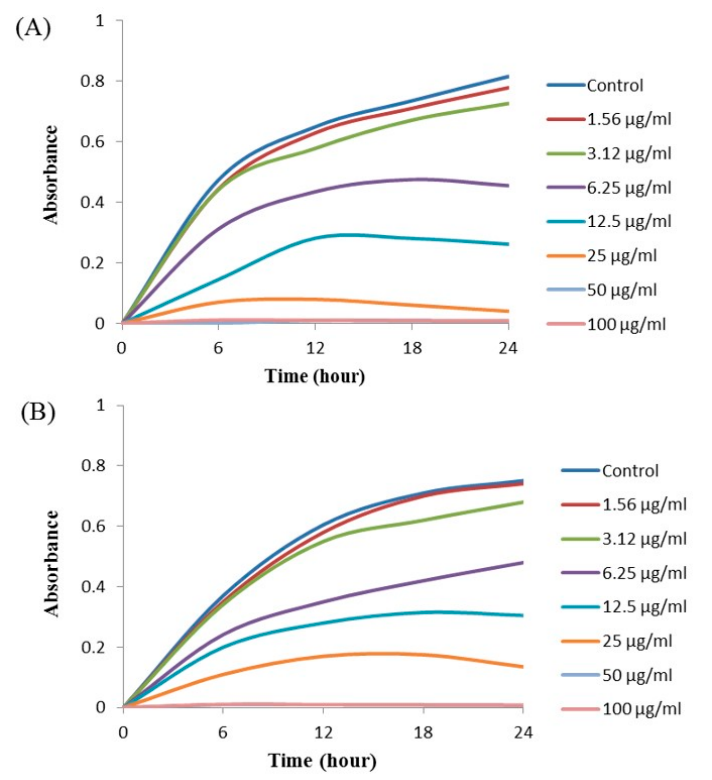
Figure 9. Growth curves of E. coli ( A ) and P. aeruginosa ( B ) cultured in Mueller–Hinton broth (MHB) with different concentrations of the synthesized AgNPs to determine the Minimal Inhibitory Concentration (MIC).